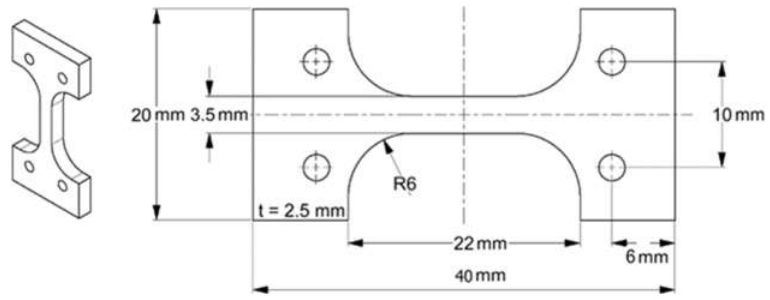
Figure 1. Drawing of a T-bone sample used for the tensile tests.